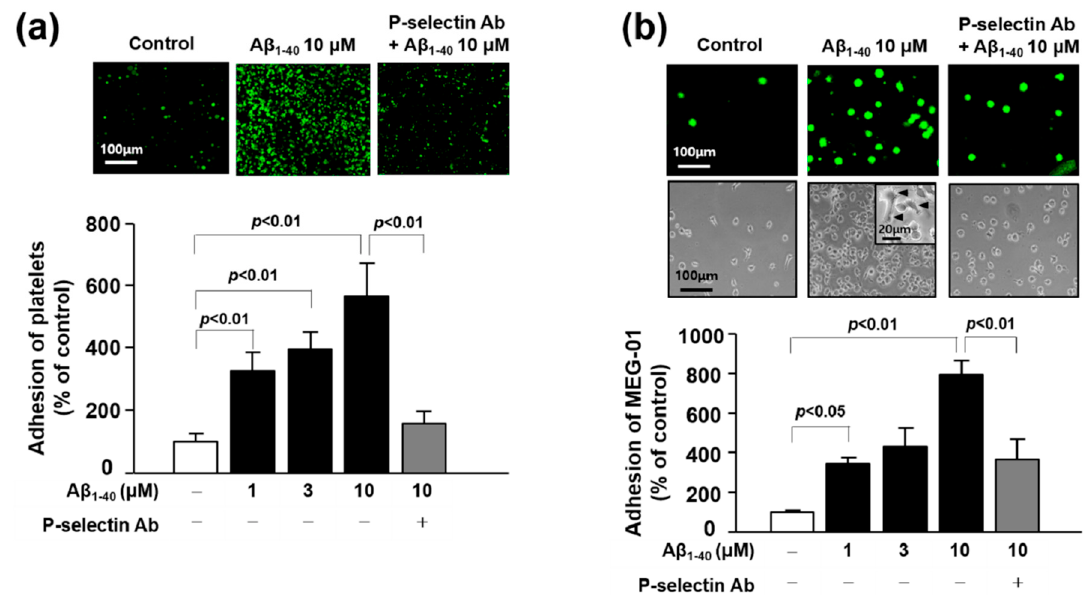
Figure 4. Role of P-selectin in the adhesion of platelets or MEG-01 cells. ( a ) Adhesion of platelets (green) was quantified following stimulation with 1, 3, and 10 µ M A β 1-40 for 1 h with or without 1 µ g / mL anti-P-selectin monoclonal antibody pre-treated for 30 min on fibronectin-coated coverslips. Data are mean ± SEM of five experiments. ( b ) Adhesion of MEG-01 cells (top, green fluorescence; bottom, phase-contrast image) was quantified following stimulation with 1, 3, and 10 µ M A β 1-40 for 1 h with or without 1 µ g / mL anti-P-selectin monoclonal antibody pre-treated for 30 min on fibronectin-coated coverslips. (insert) Arrowhead indicates spreading of MEG-01 cells. Data are mean ± SEM of six experiments.